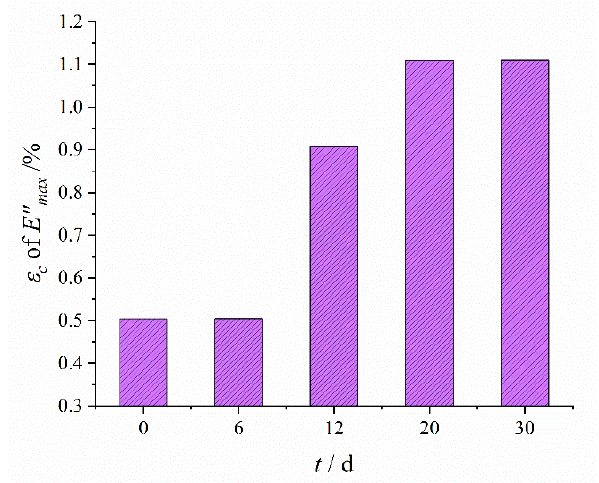
Figure 9. Changing results of the difference of storage modulus with aging time.